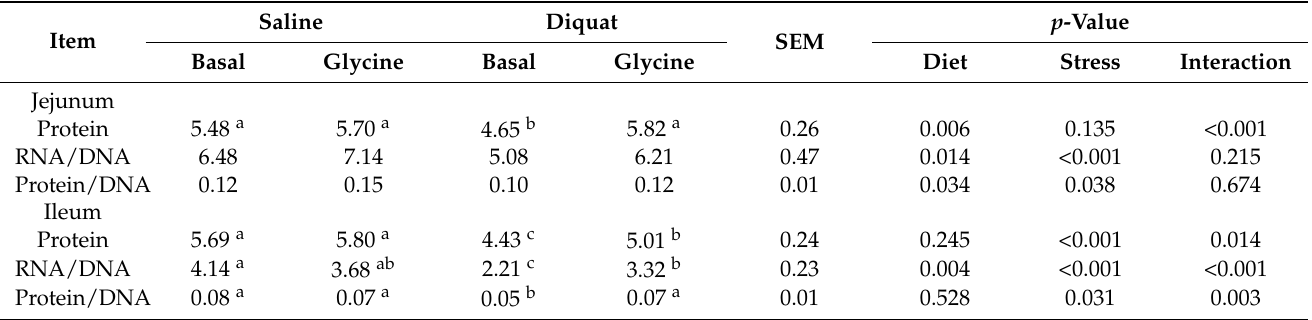
Table 4. The contents of intestinal mucosal protein (mg/g tissue), RNA/DNA, and protein/NDA (mg/ µ g) of the piglets fed glycine diets under oxidative stress.